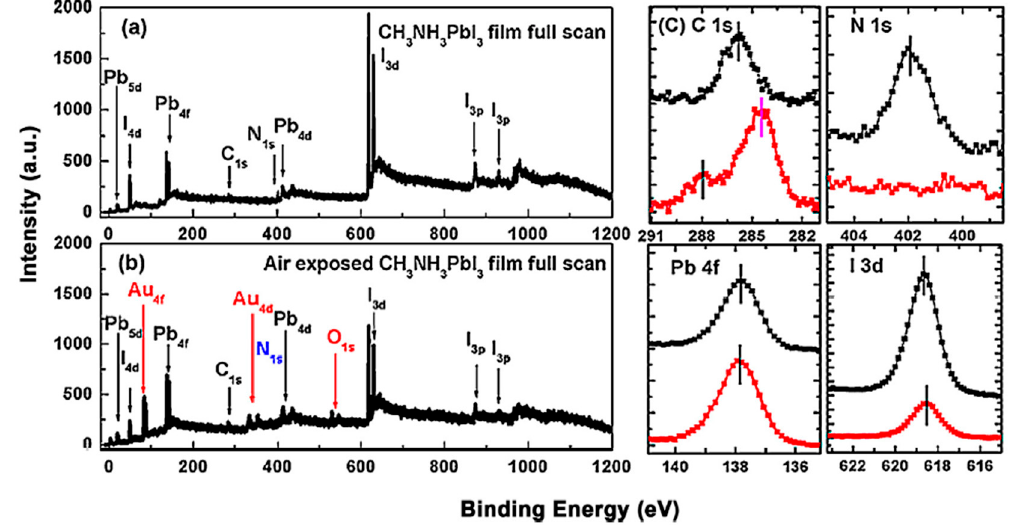
Figure 2. ( a ) XPS full scan of co-evaporated MAPbI 3 thin film and ( b ) XPS full scan of air-exposed film. ( c ) XPS spectra comparisons of C 1s, N 1s, Pb 4f, and I 3d core levels. From Ref. [35]. with permission.